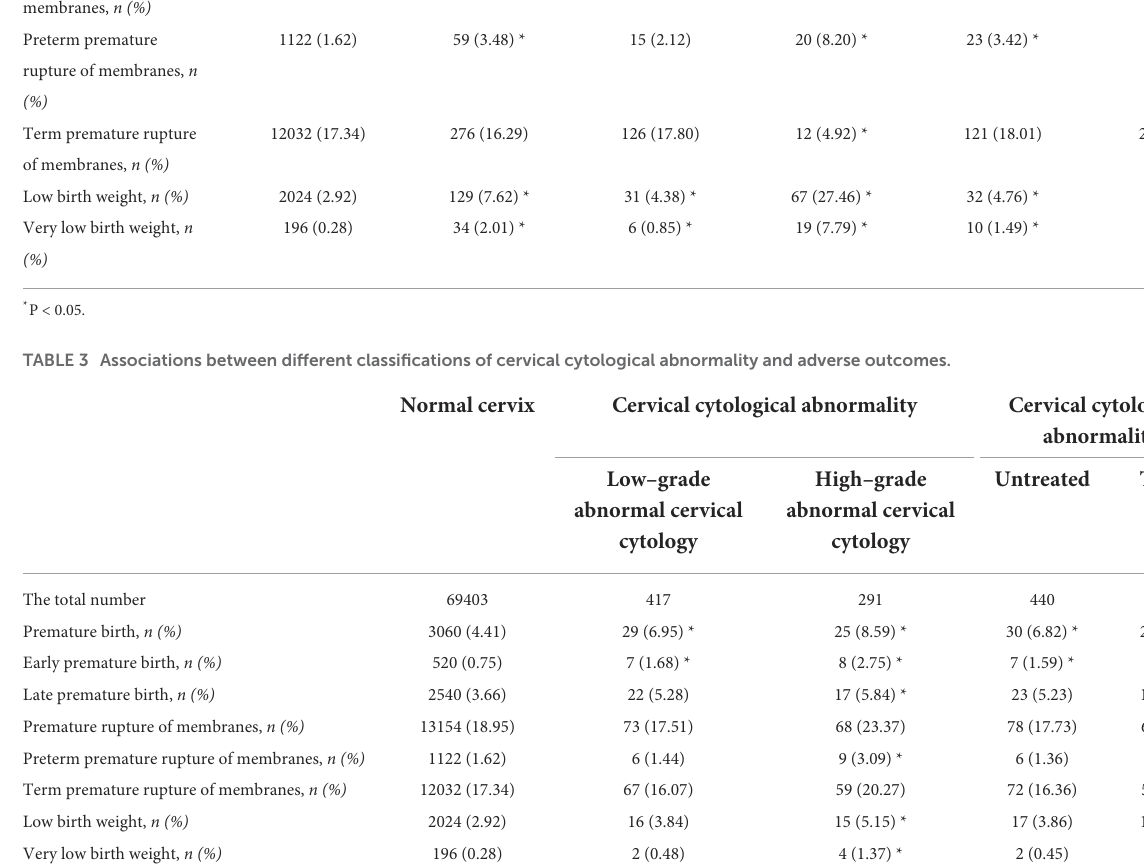
History of cervical surgery